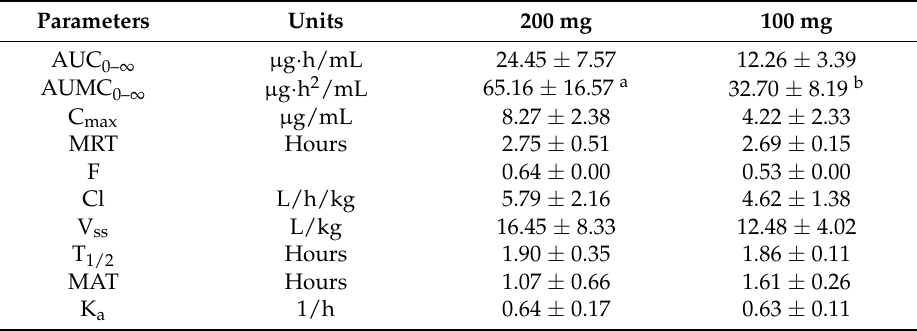
Figure 3. Semi-log concentration–time curve for salicylic acid after 100 and 200 mg/kg treatments of oral SS in six sheep (mean ± SD). Table 2. Average of all non-compartment pharmacokinetic parameters of salicylic acid after single oral doses of SS in sheep (mean ±